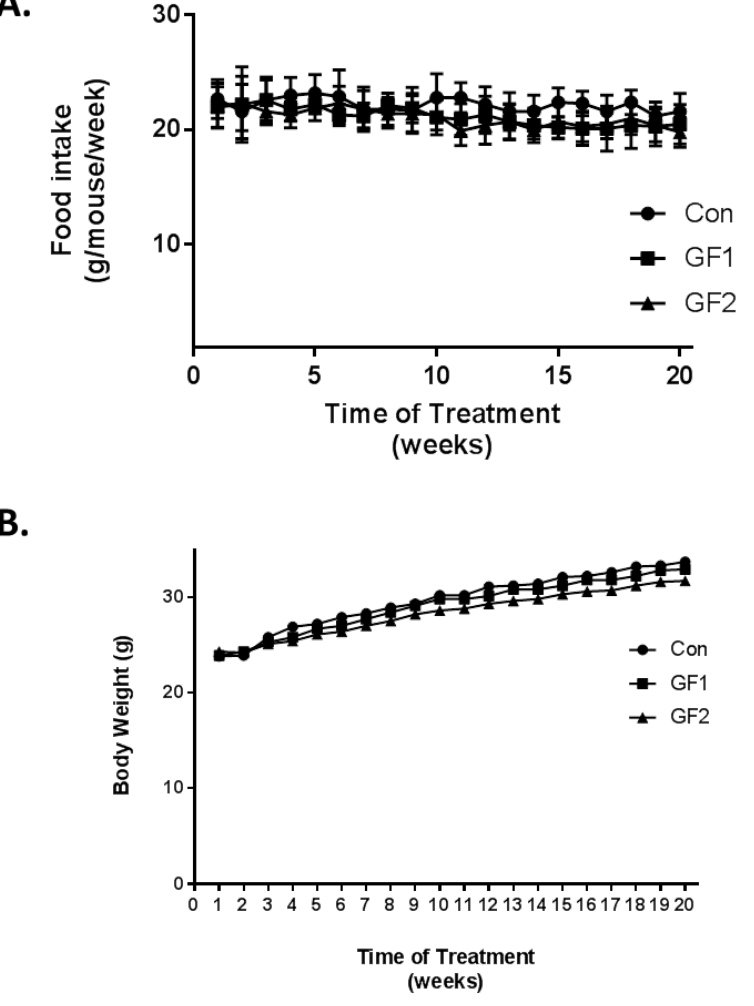
Figure 1. Effects of GF diets on food intake and body weight. ( A ) Food intake changes in 10 weeks. ( B ) Body weight changes in mice on various diets over 10 weeks. Mice were fed a normal diet or diets that were supplemented with 2% GF. Each point represents mean ± SD ( n = 10 per group).